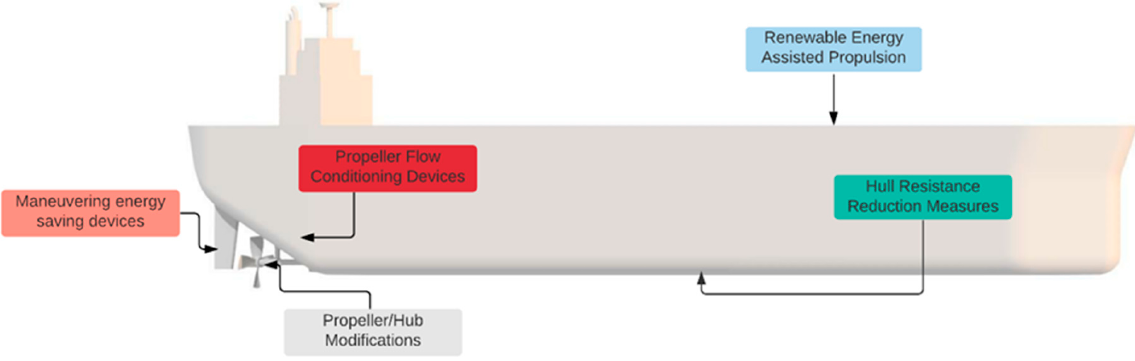
Figure 3. General application of energy-saving devices (ESDs) from a location point of view.